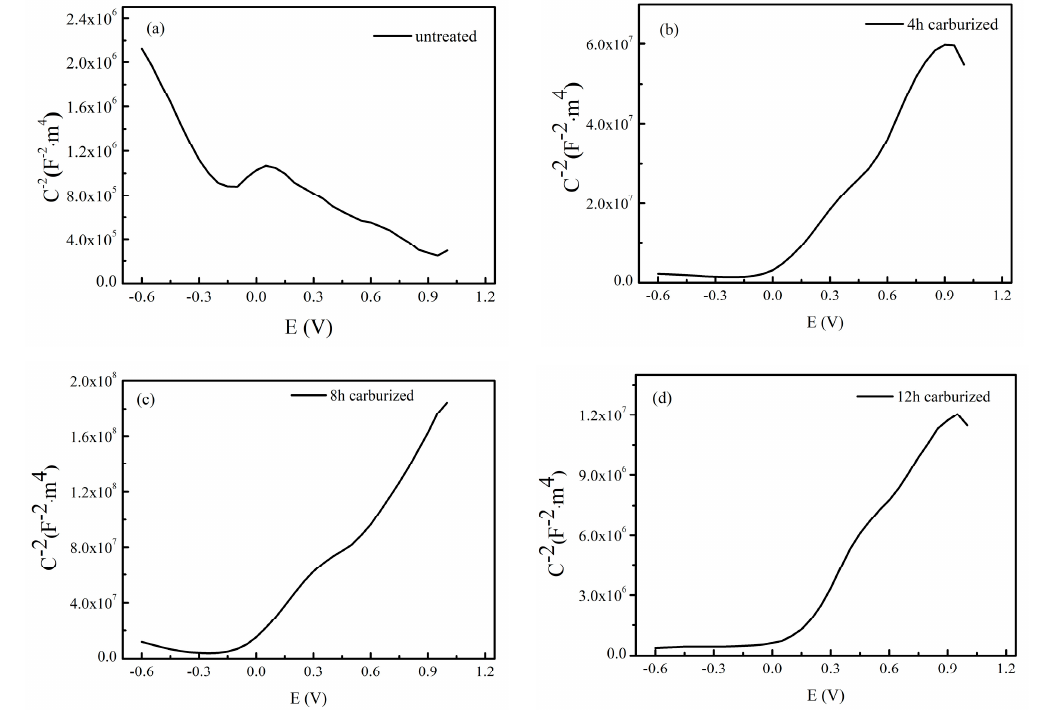
Figure 5. Mott–Schottky (M–S) plots of the untreated and the carburized AISI 420 stainless steel: ( a ) untreated; ( b ) 4 h carburized; ( c ) 8 h carburized; ( d ) 12 h carburized.